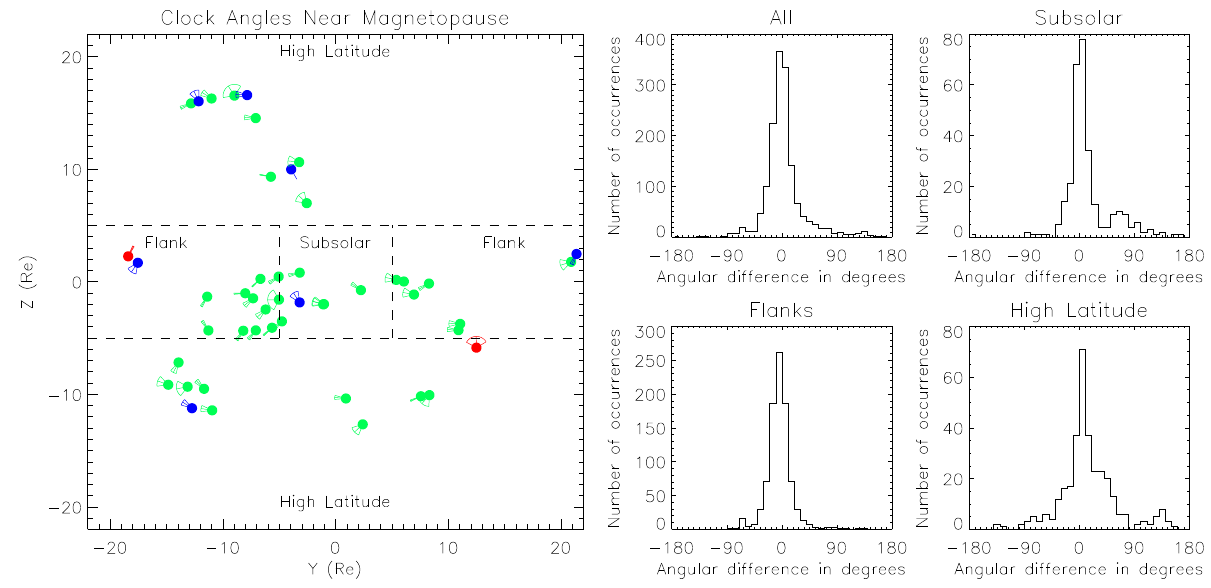
Fig. 7. Clock angles measured near magnetopause, and angular differences from perfect draping, for IMF with B y negative. Format as Fig. 2.